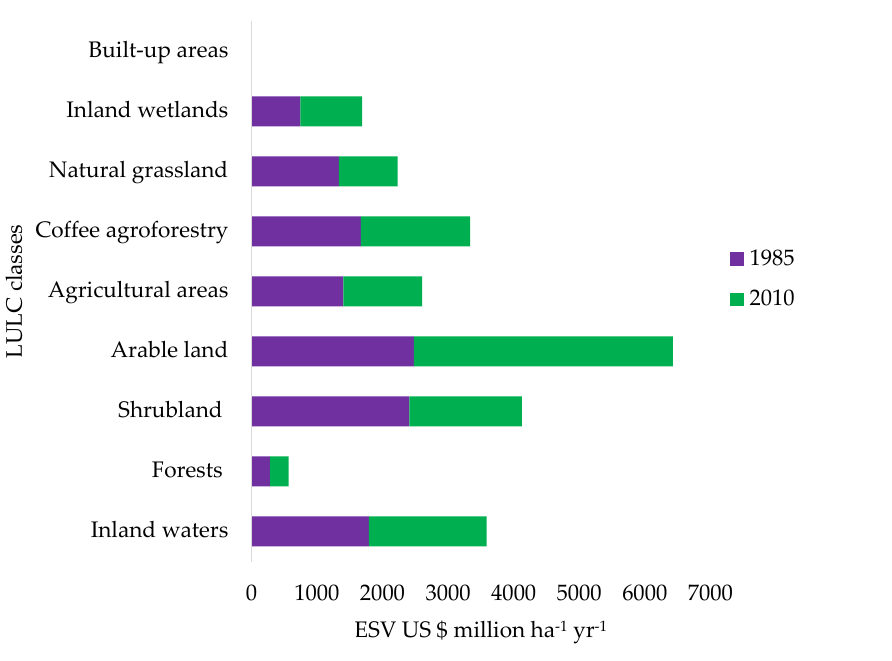
Figure 16. ESV from 2000 to 2020 in Abaya-Chamo Basin, Ethiopia (Source of data: Woldeyohannes et al. [73], but figure done by authors).